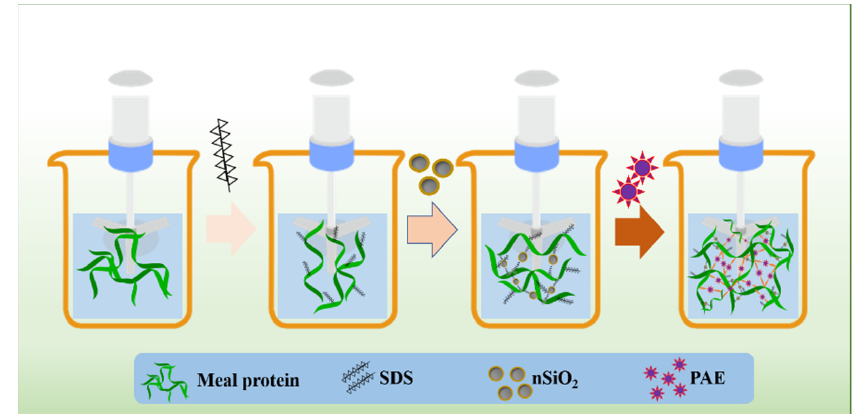
Figure 1. Scheme of the preparation of HPMP ‐ , SBMP ‐ , and CSMP ‐ based adhesive. Table 1. Compositions of the HPMP ‐ , SBMP ‐ , and CSMP ‐ based adhesive.